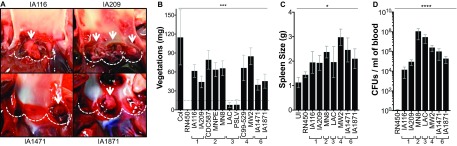
The ability of USA100 and USA600 strains to cause infective endocarditis is similar to that of well-established USA200 and USA400 strains in the rabbit model of infective endocarditis and sepsis. (A) Representative images of aortic vegetations caused by USA100 strains IA116 and IA209 (top) and USA600 strains IA1471 and IA1871 (bottom). Dotted lines outline valve cusps. Arrows indicate vegetations. (B) Total mean weights of vegetations dissected from aortic valves (±standard errors of the means) after intravenous inoculation with 1 × 107 to 5 × 108 CFU, as described in Materials and Methods. Values above the dotted line are significantly different than those below. ***, P = 0.0002 by one-way ANOVA and Holm-Sidak multiple-comparison test. (C) Enlargement of the spleen resulting from S. aureus infection. UI, uninfected. *, P = 0.01 by one-way ANOVA. (D) Bacterial counts per milliliter of blood recovered from rabbits postmortem. ****, P < 0.0001 by one-way ANOVA; P values of ≤0.05 are considered statistically significant. 1, USA100; 2, USA200; 3, USA300; 4, USA400; 6, USA600.